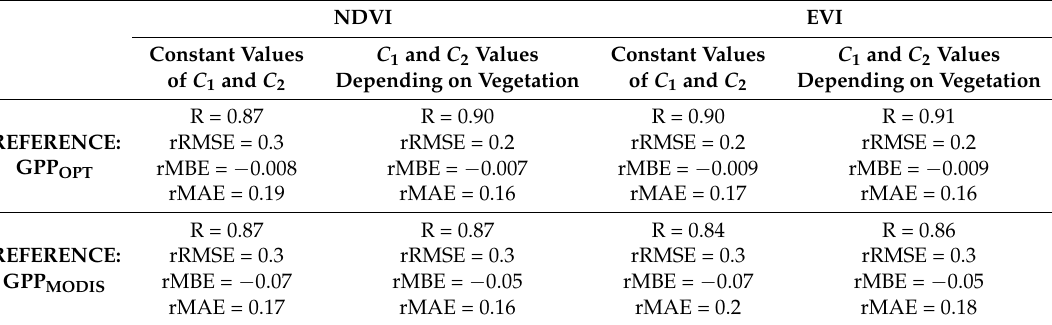
Table 6. Summary of the validation statistics (R, rRMSE, rMBE and rMAE) of the semi-empirical model estimates when driven by NDVI and EVI (with and without a vegetation map) and using as